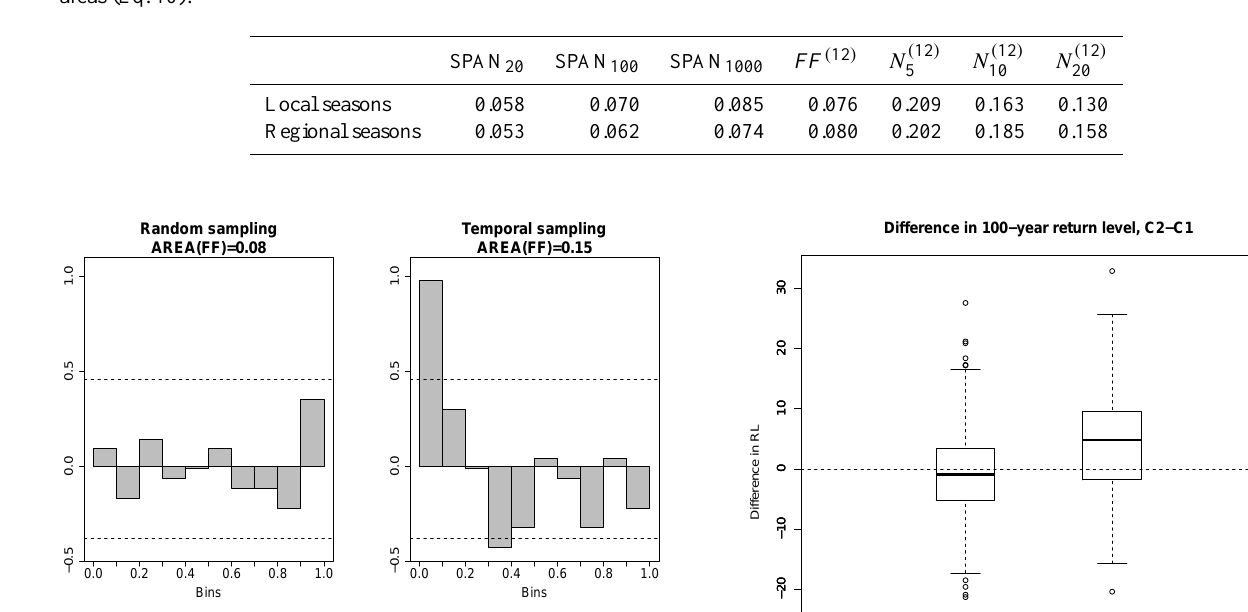
Figure 10. Divergence in density between ff ( 12 ) and the uniform case, under random sampling (left) and temporal sampling (right), with corresponding scores AREA (FF) . The closer the bars are to 0, the better the fit is. The dotted horizontal lines show 95% confi- dence interval for uniform variates.